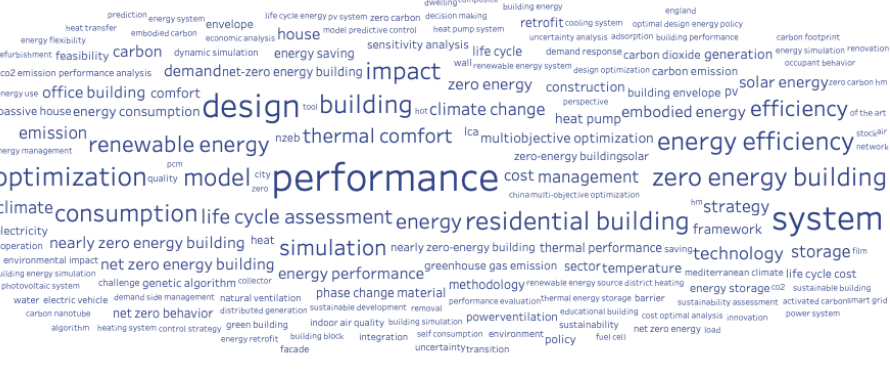
Figure 3. Keyword word cloud.